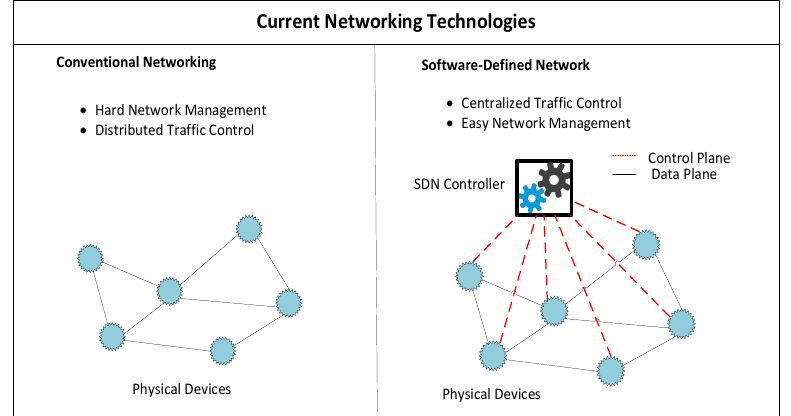
Figure 2. Current network